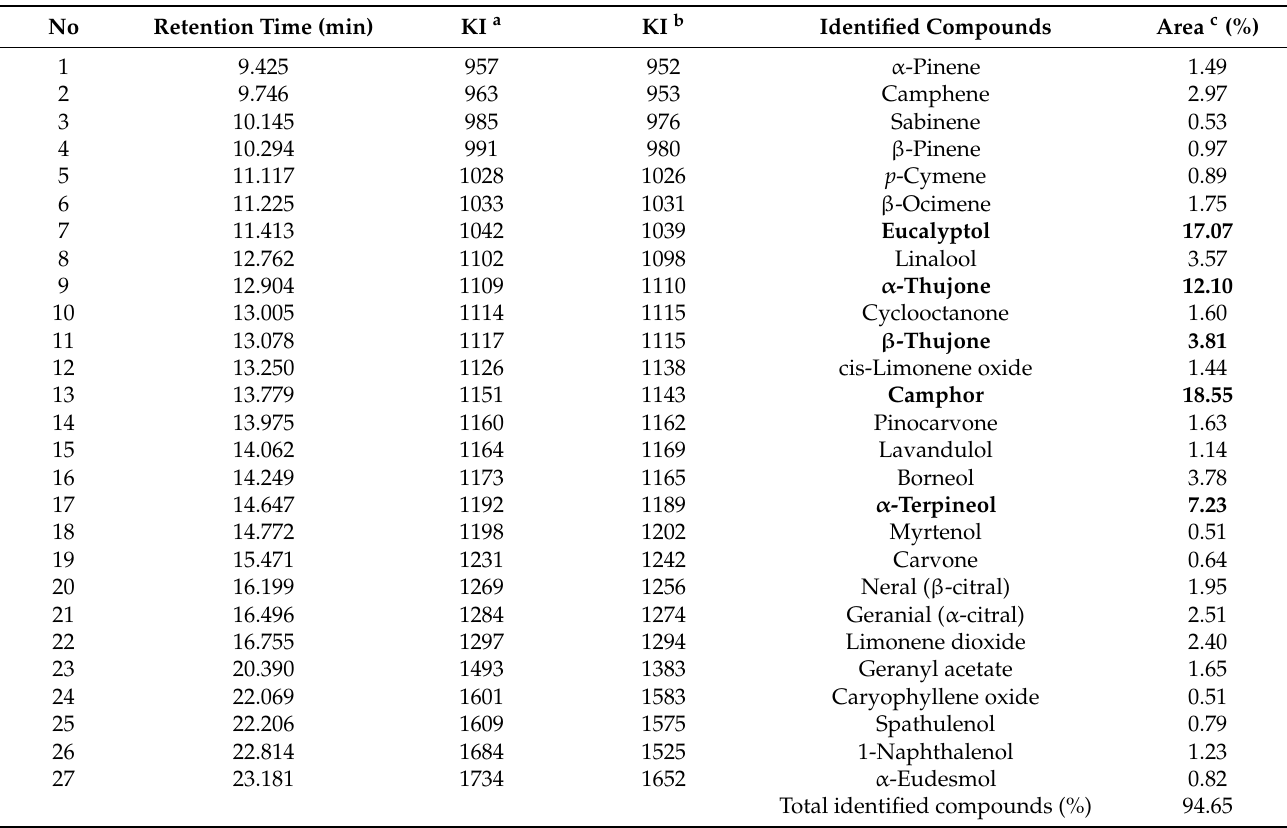
Table 2. Identified chemical components of Yarrow ( Achillea millefolium L.) essential